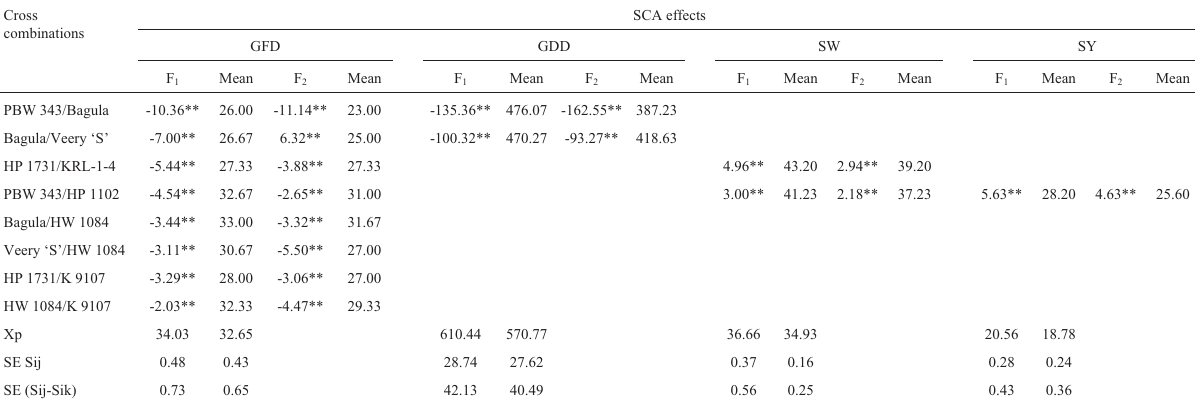
Table 5 - Estimates of desirable specific combining ability (SCA) effects for the F 1 and F 2 offspring of 11 wheat parents for grain filling duration (GFD), GFD for growing degree days (GDD), 1000 seed weight (SW) and seed yield (SY) per